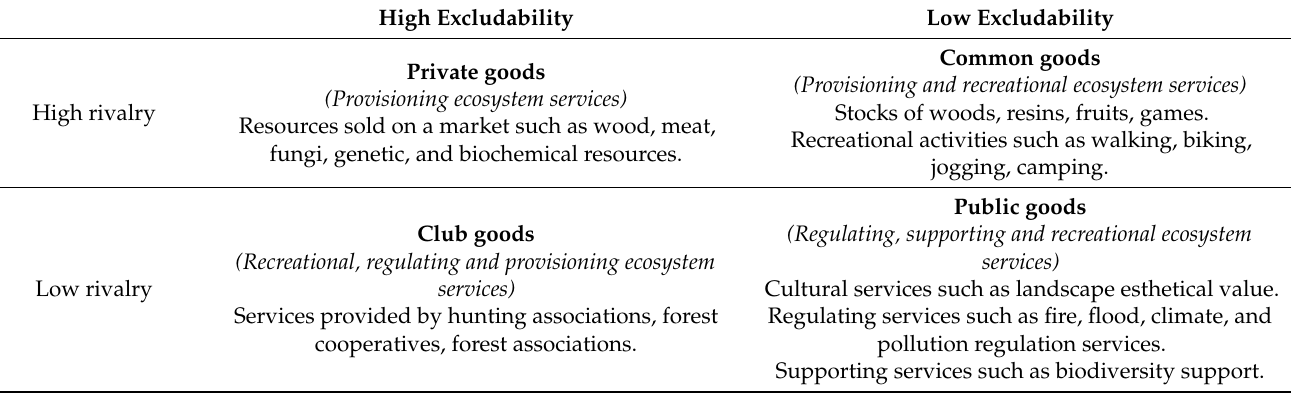
Table 2. The different types and levels of public and private goods related to forest resources and services. These types have important economic and social